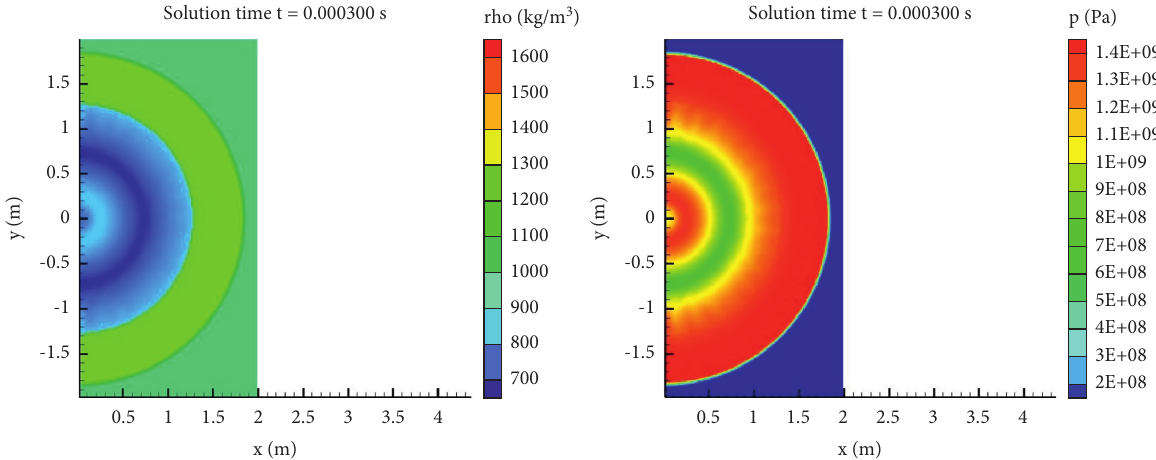
Figure 14: 2D axisymmetric density and pressure contours of Case 4 at 0 . 3 × 10 − 3